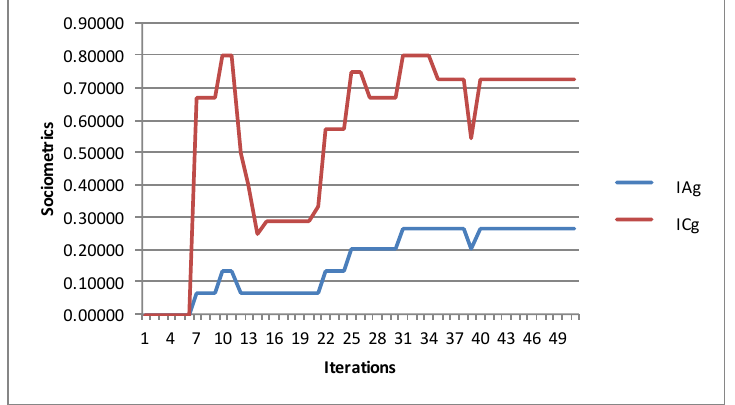
Figure 9. Temporal evolution of the Index of Association of a group (IAg) and the Index of Coherence of a group (ICg) sociometrics in a simulation execution for the scenario of Barrasa and Gil [12].